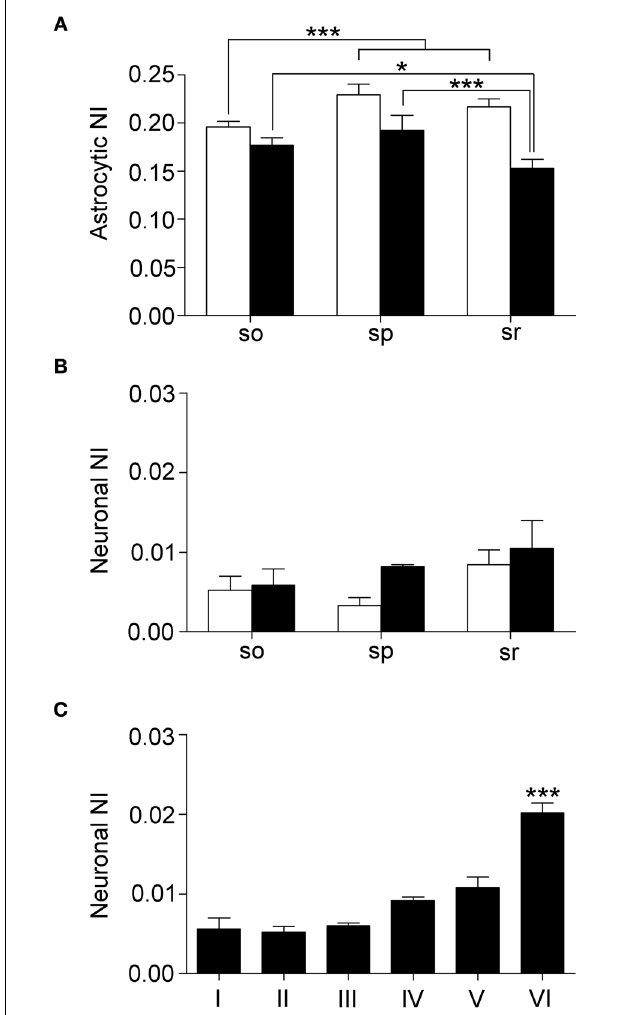
FIGURE 6 | Laminar analysis of fl uorescence intensity in astrocytes and neurons. (A) shows NI in astrocytes from stratum oriens (so), pyramidale (sp), and radiatum (sr) of CA1 ( white columns ) and CA3 ( black columns ). (B) illustrates neuronal NI in stratum oriens (so), pyramidale (sp), and radiatum (sr) of CA1 ( white columns ) and CA3 ( black columns ). (C) neuronal NI in layers I-VI of SI. Values are mean ± sem. * P < 0.05, *** P <